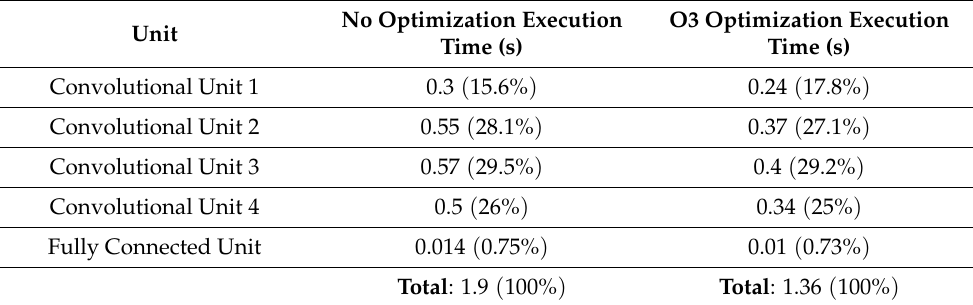
Table 11. Execution time of the ECG-ID-BNet IOb-SoC @ 100 MHz, software only implementation.